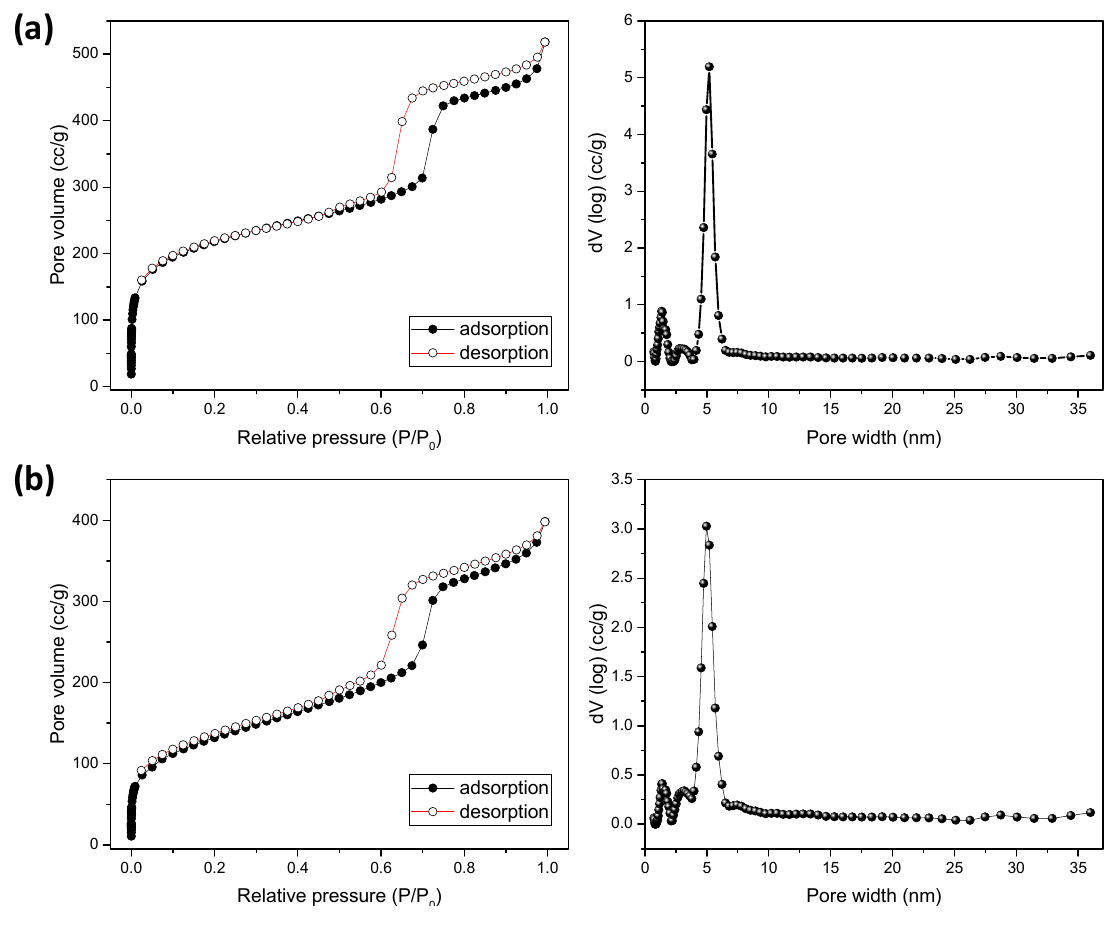
Figure 5. Nitrogen adsorption–desorption isotherms (left) and pore size distributions calculated by the density functional theory (DFT) method (right) of EthanePMO ( a ) and EthanePMO@NCOFeFe ( b ). Table 1. Textural properties of EthanePMO and EthanePMO@NCOFeFe